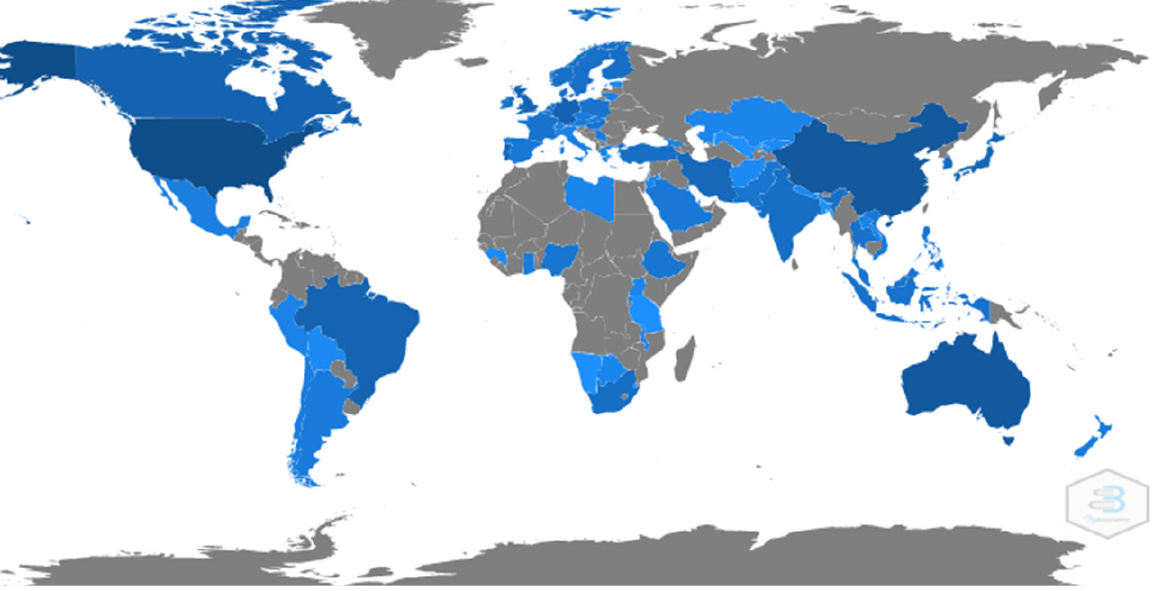
Figure 6. Countries with the highest scientific production in HL and HE. The more intense the blue, the greater the contribution to scientific production. In grey, countries without scientific production identified in this topic.